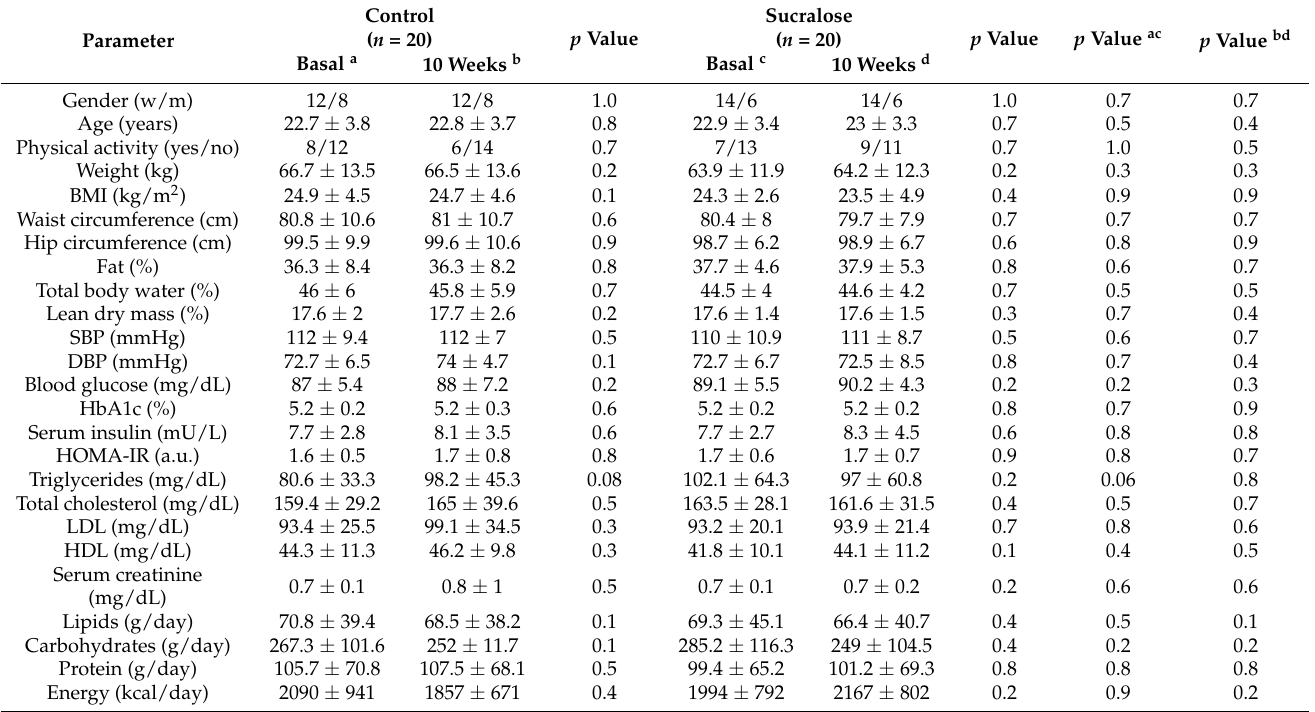
Table 1. Demographic, anthropometric, and biochemical characteristics of the participants at the beginning and end of the